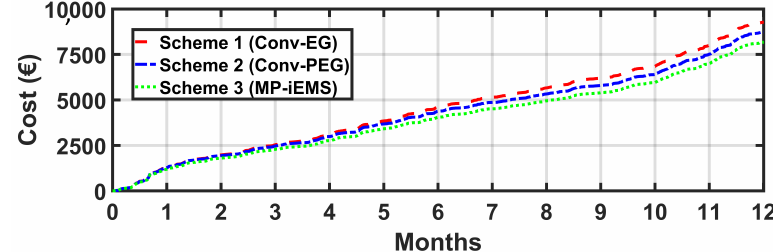
Figure 14. Total energy cost.